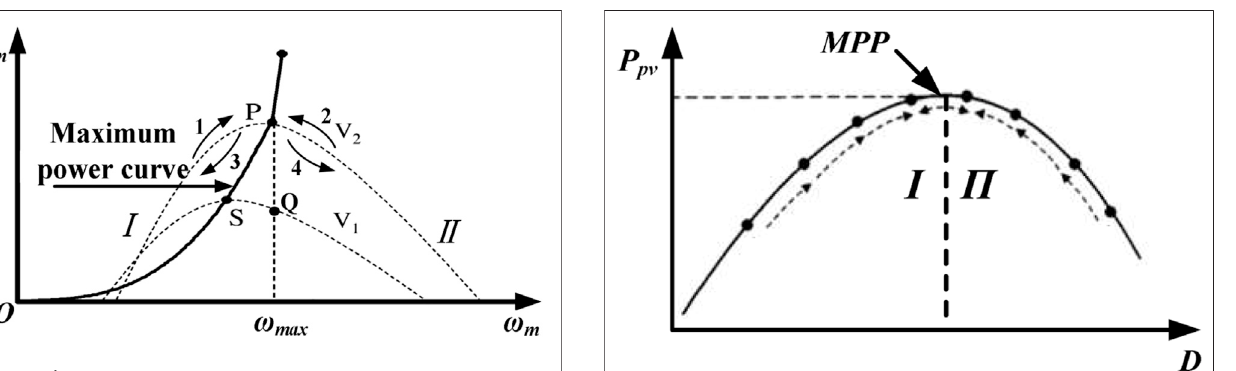
FIGURE 3 | Characteristic curve of WT generation.